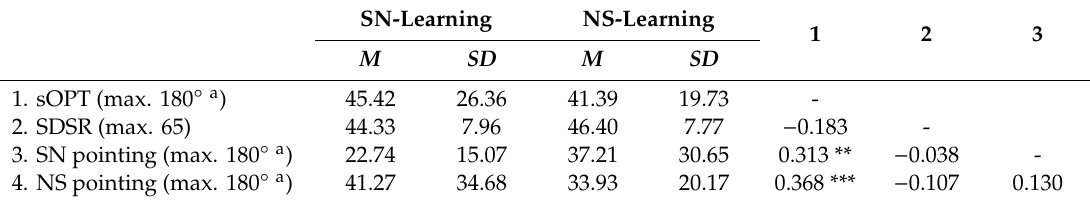
Table 1. Means and standard deviations by learning condition (SN = south to north or NS = north to south) and correlations between all measures of